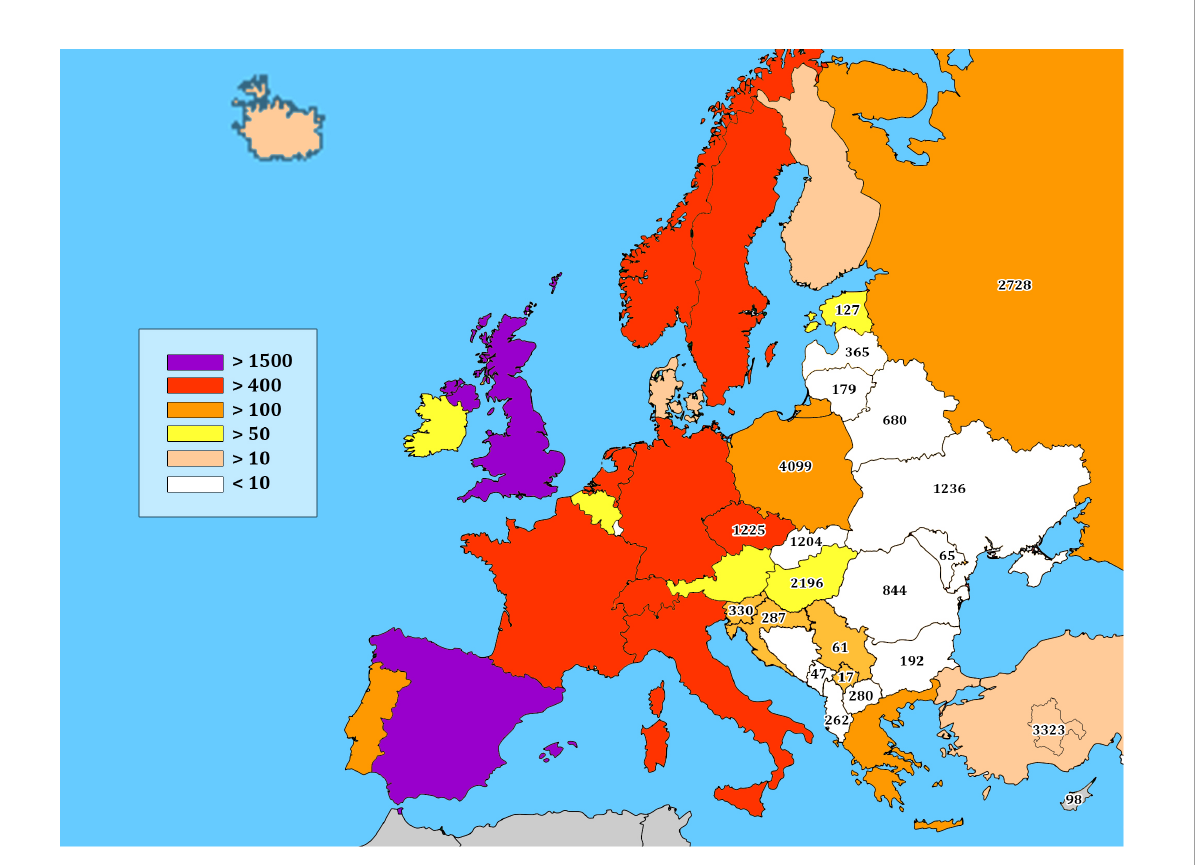
FIGURE 1 Number of patients with inborn errors of immunity reported from Eastern and Central Europe (ECE) to the ESID Registry in 2000 was less than 10 (see color coding and the scale on the left). Number of patients reported to this J Project survey at the end of 2021 is shown by numbers in ECE countries. For more details see Table